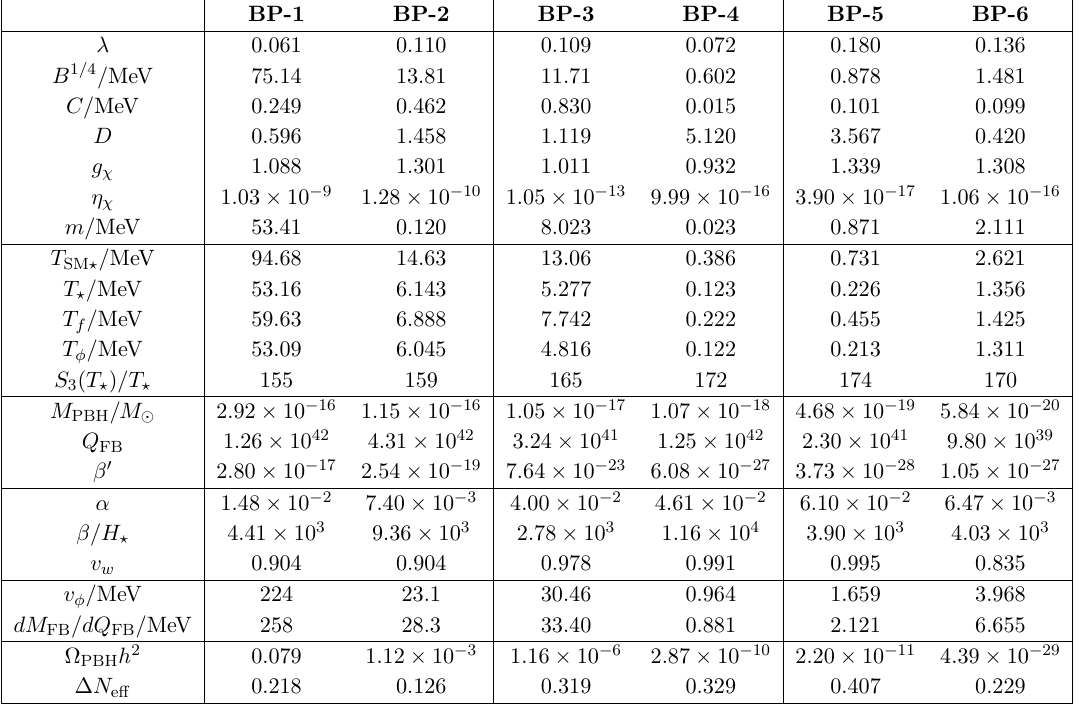
Table 1 . Benchmark points with A = 0 . 1 fixed. T f is the temperature of the dark sector after the FOPT. α is the strength of the transition, defined by the ratio of the latent heat released and the radiation energy density at the time of the FOPT, and β is the inverse duration of the phase